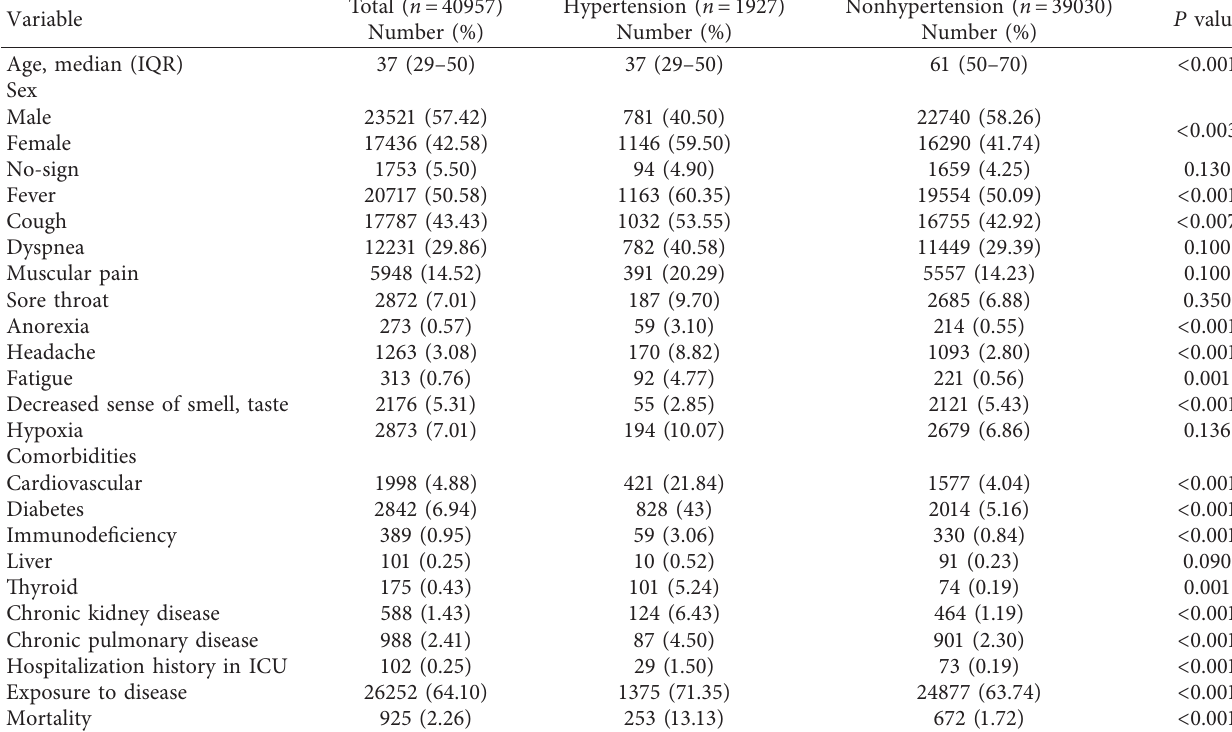
Table 1: The characteristics of hypertensive and nonhypertensive patients with